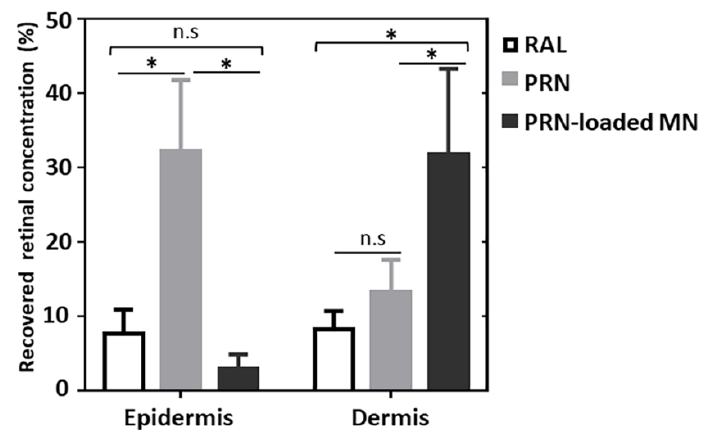
Figure 6. The average percentage of recovered retinal concentrations in epidermis and dermis after topical application as PRN, conventional RAL or PRN-loaded MN. (n = 6, mean ± SD) (* p < 0.05 and n.s. for p > 0.05).